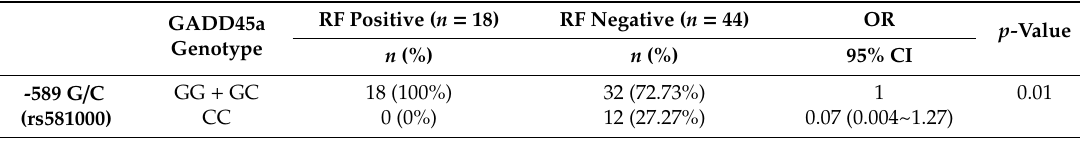
Table 6. Genotypes frequency of -589G / C GADD45a gene in RF-positive and RF-negative SLE patients. GADD45a